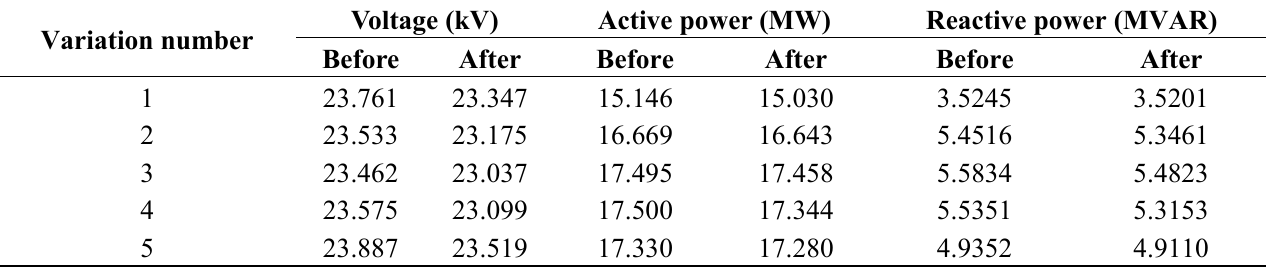
Table 5. Korean EMS data for the 346th transformer bank on summer